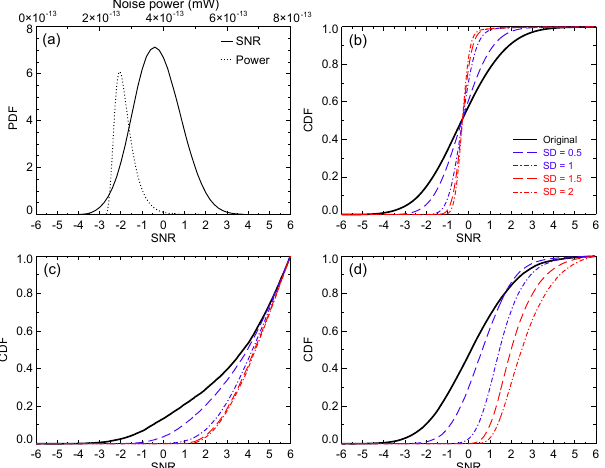
Figure 1. (a) Probability distribution function (PDF) of the noise power and SNR from the KAZR observations on a clear day, 21 Jan- uary 2014. (b) Cumulative distribution function (CDF) of original and convolved SNR of the noise on the clear day. (c) and (d) CDF of original and convolved SNR of a cloudy case on 4 January 2014 for range gates inside and outside the cloud adjacent to the cloud boundary, respectively. The converted SNR is obtained by using a 2-D Gaussian distribution kernel (Eq.